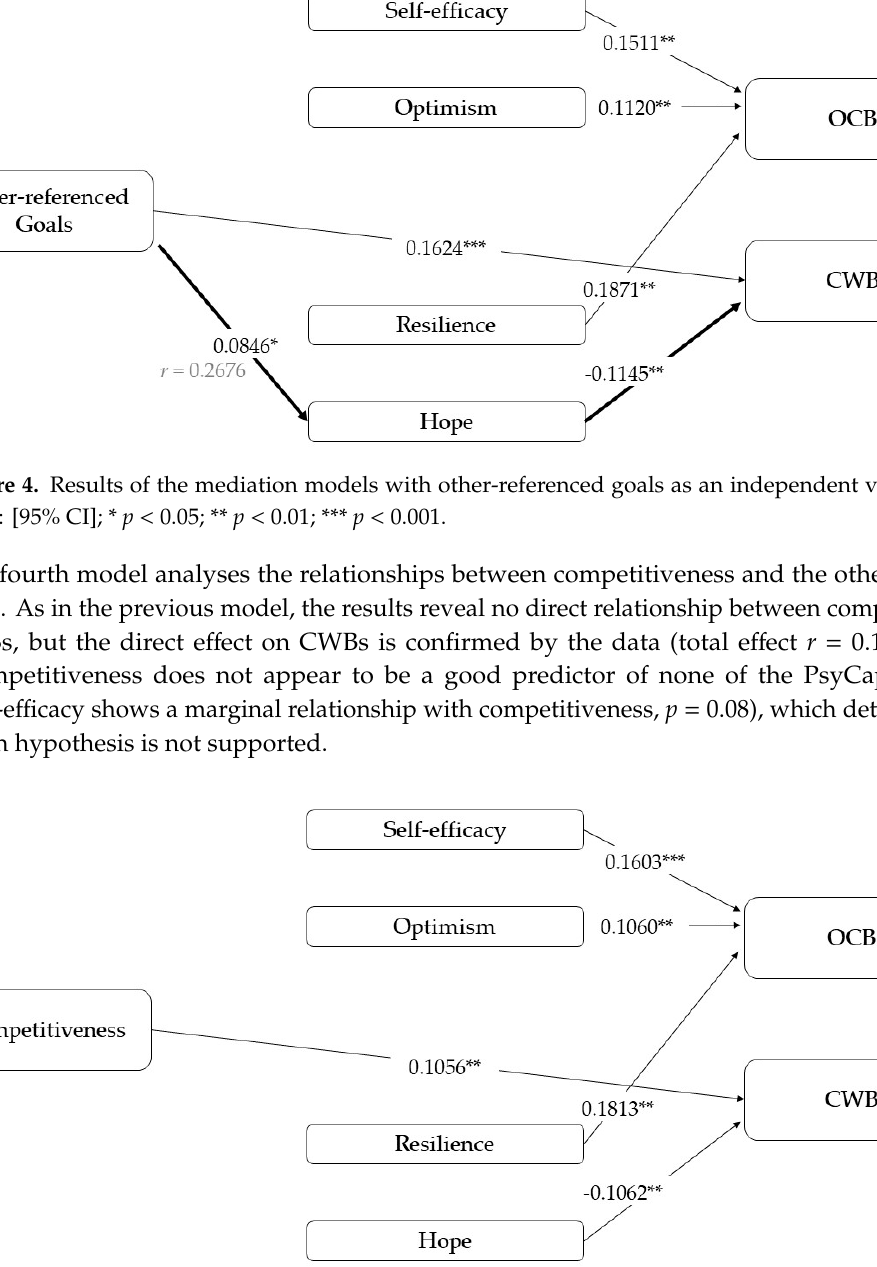
Figure 5. Results of the mediation models with competitiveness as an independent variable. Note: [95% CI]; ** p < 0.01; *** p < 0.001.